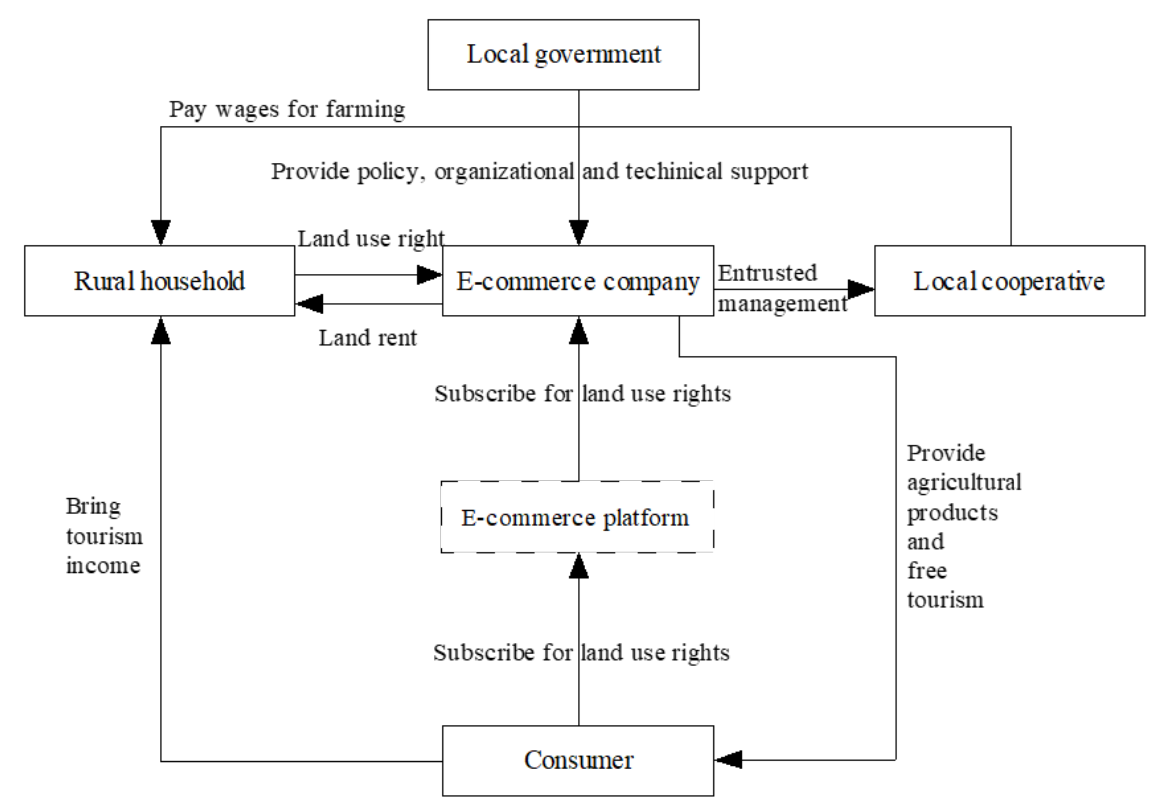
Figure 2. The basic operating mechanism of the Jutudi model.